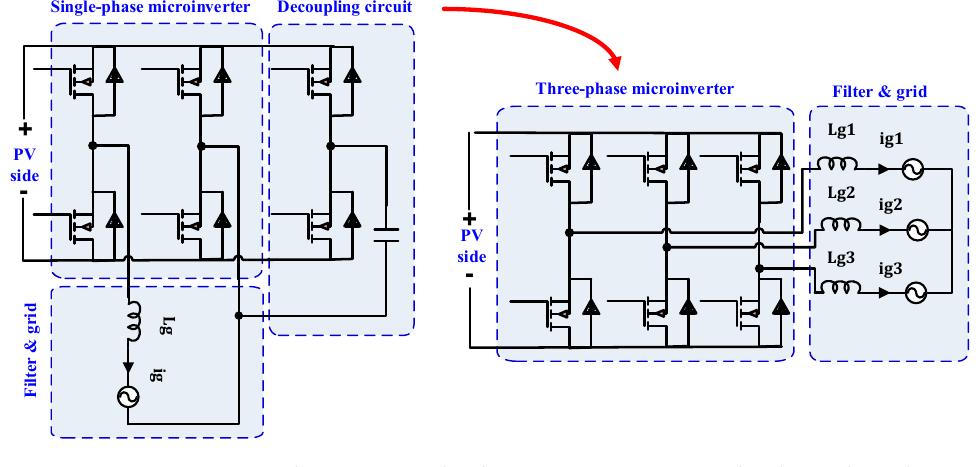
Figure 2. Comparison between single-phase microinverter with decoupling leg and three-phase microinverter.